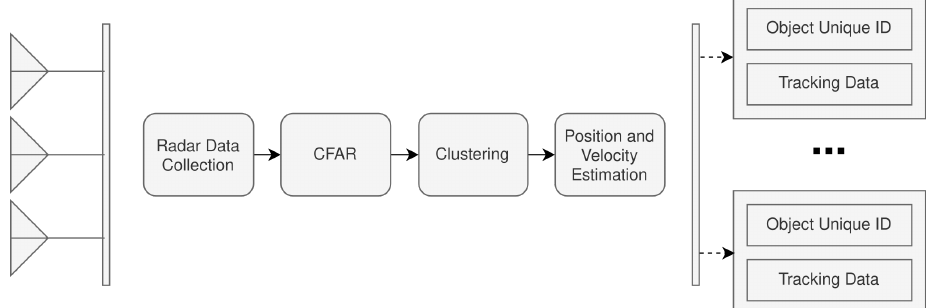
Figure 4. Radar-processing pipeline